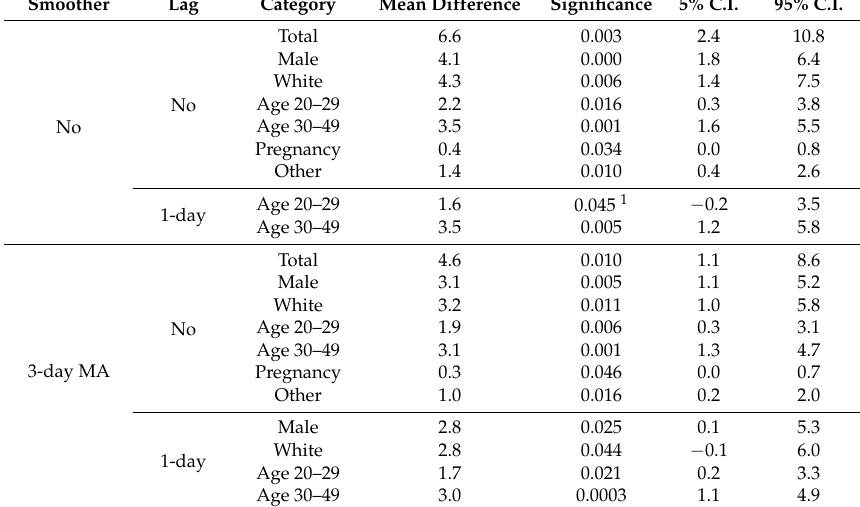
Table 4. Summary of paired t -test results for 35 ◦ C AT threshold heat waves. Categories with statistically significant differences between admissions for the heat wave case and control days, bootstrapped significance level ( p -value), and bootstrapped 5th and 95th percentile confidence intervals about the mean difference in admissions. Tests were run for lags of zero and one day and for unsmoothed and data smoothed using a 3-day centered moving average (MA)